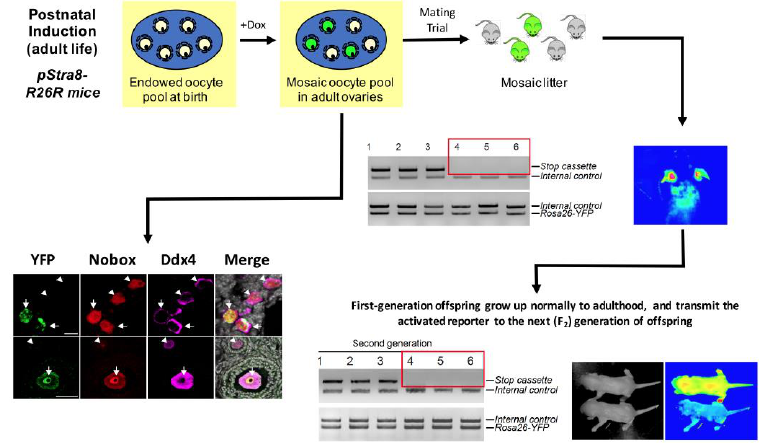
Figure 1. Oocytes formed during adult life in mice contribute directly to offspring production. Schematic representation of an inducible genetic lineage-tracing model to ‘mark’ new oocytes formed during the doxycycline (dox) induction phase, which specifically activates a triple-transgenic Cre- loxP –based reporter system tied to stimulated by retinoic acid gene 8 ( Stra8 ) expression in pre-meiotic germ cells (viz. OSCs) committing to meiosis followed by de novo oogenesis. Portions of this figure were adapted with permission from Wang et al.